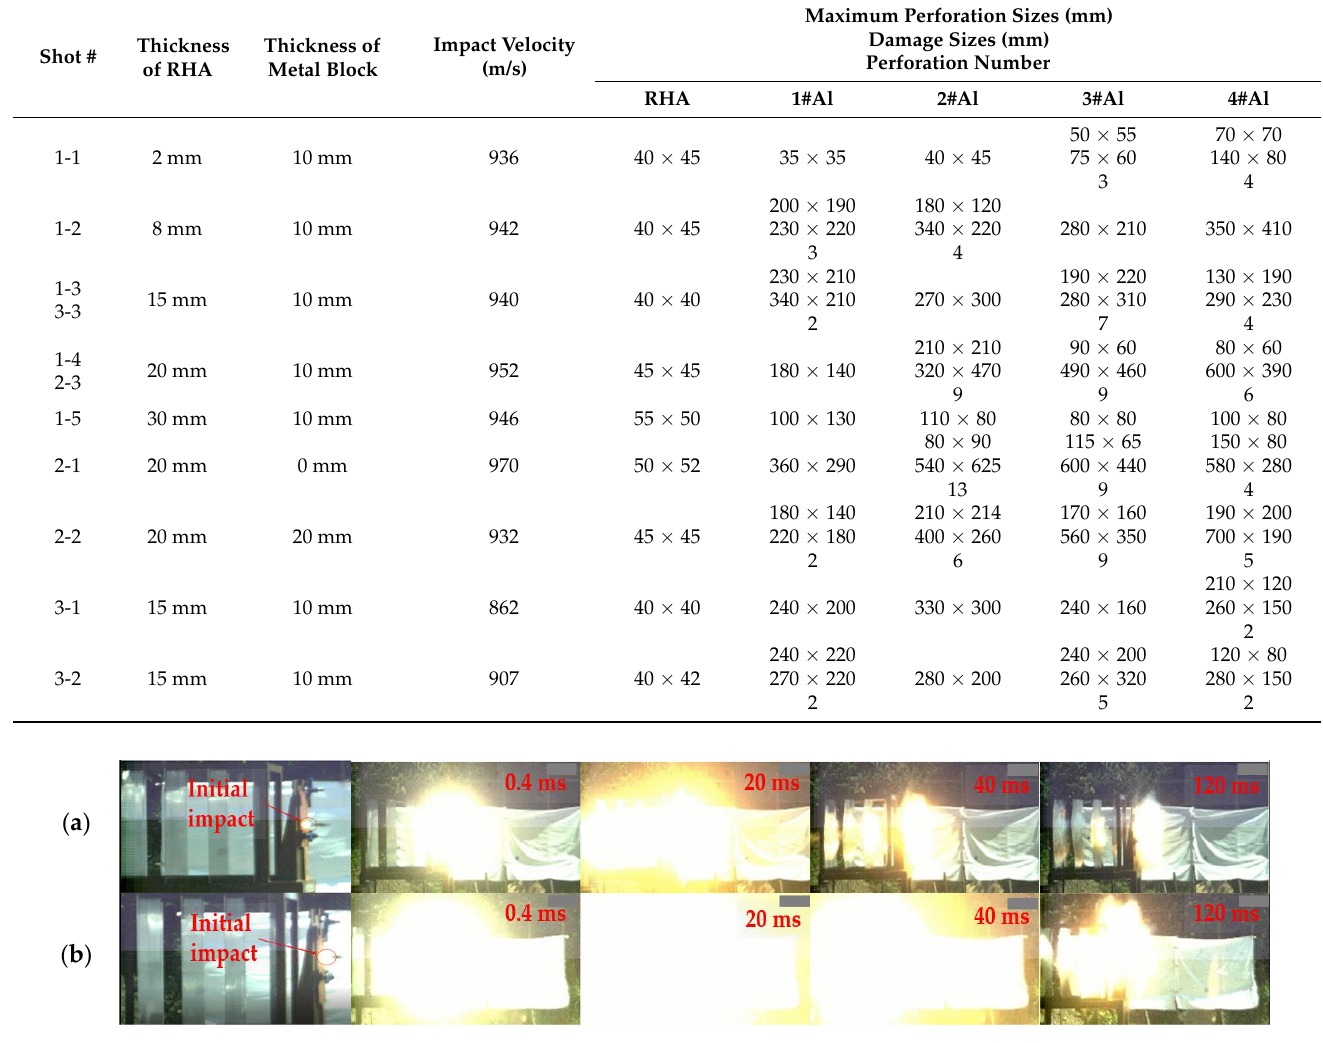
Figure 17. Comparison of high-speed images of RMP hitting MLAT: ( a ) hitting a 2 mm RHA steel